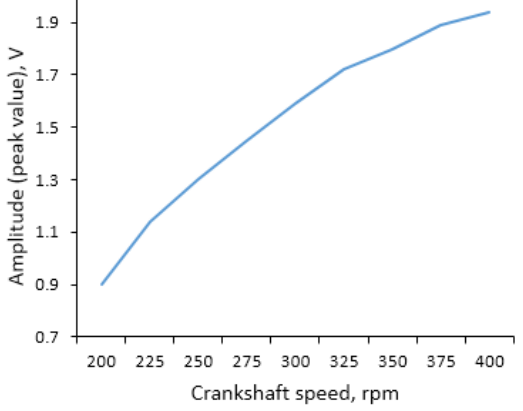
Figure 8. The dependence of the vibration impulse on the impact of the piston on the tip (set 0.01 mm before